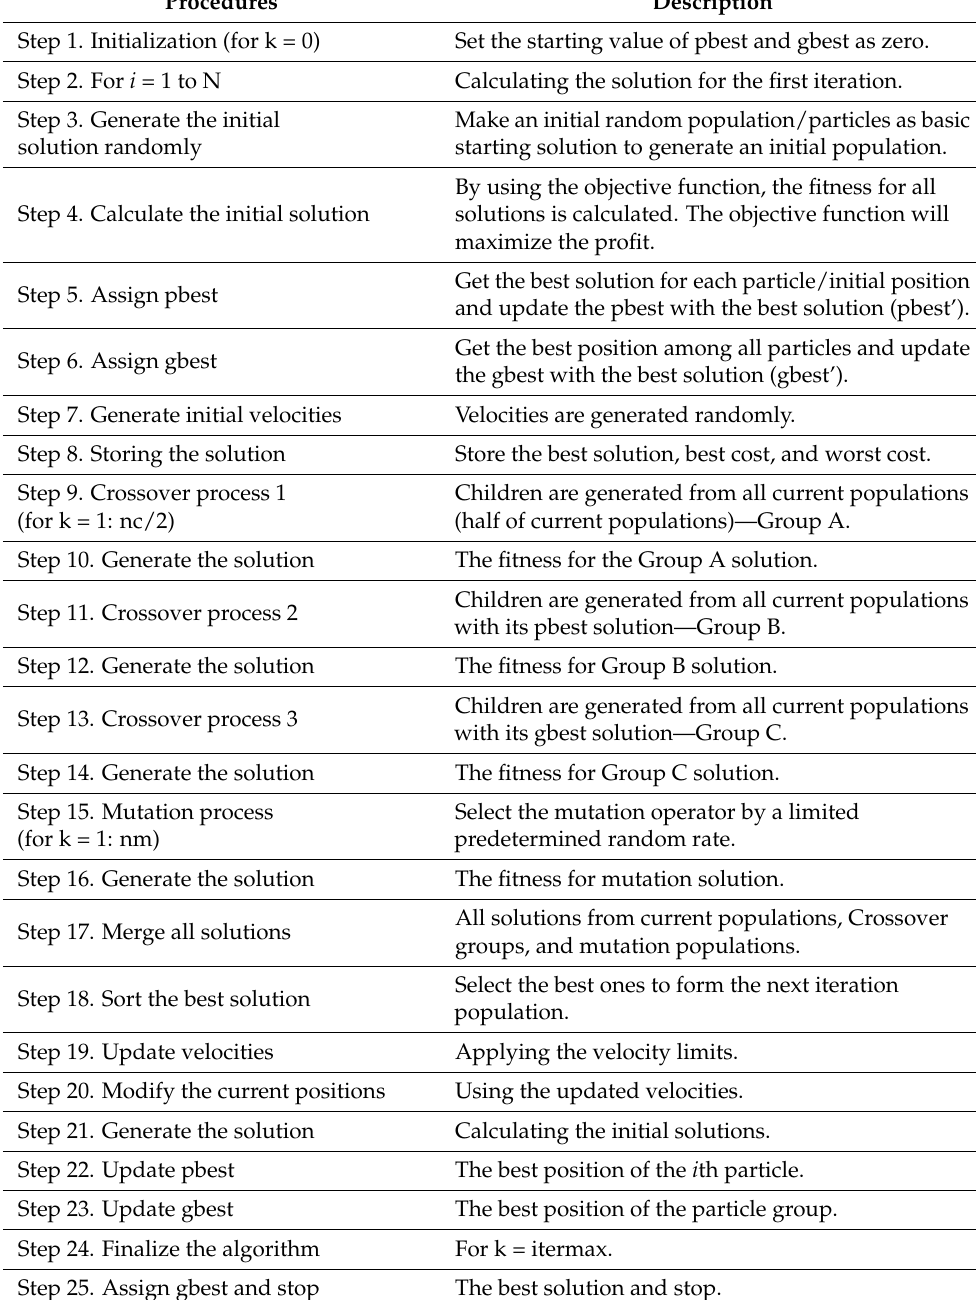
Table 5. The procedures of the proposed PSO-GA model. Procedures